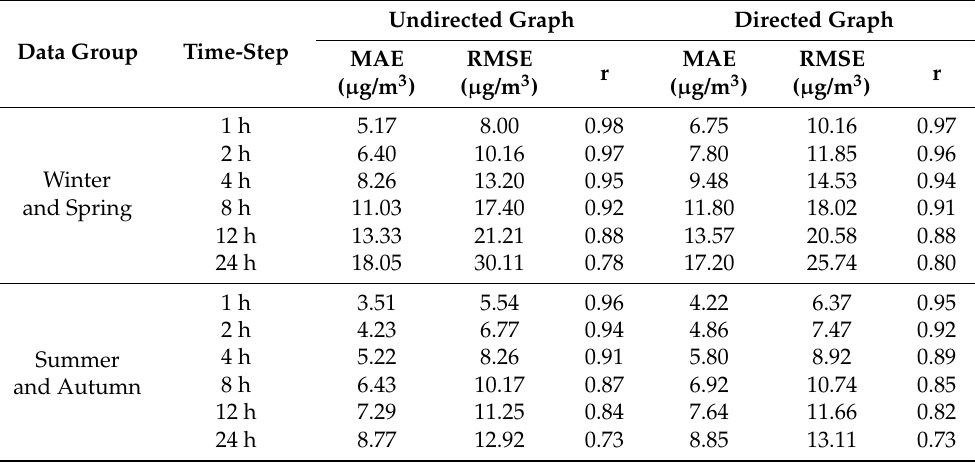
Table 3. The performance of the DCRNN model in forecasting PM 2.5 concentrations at different time